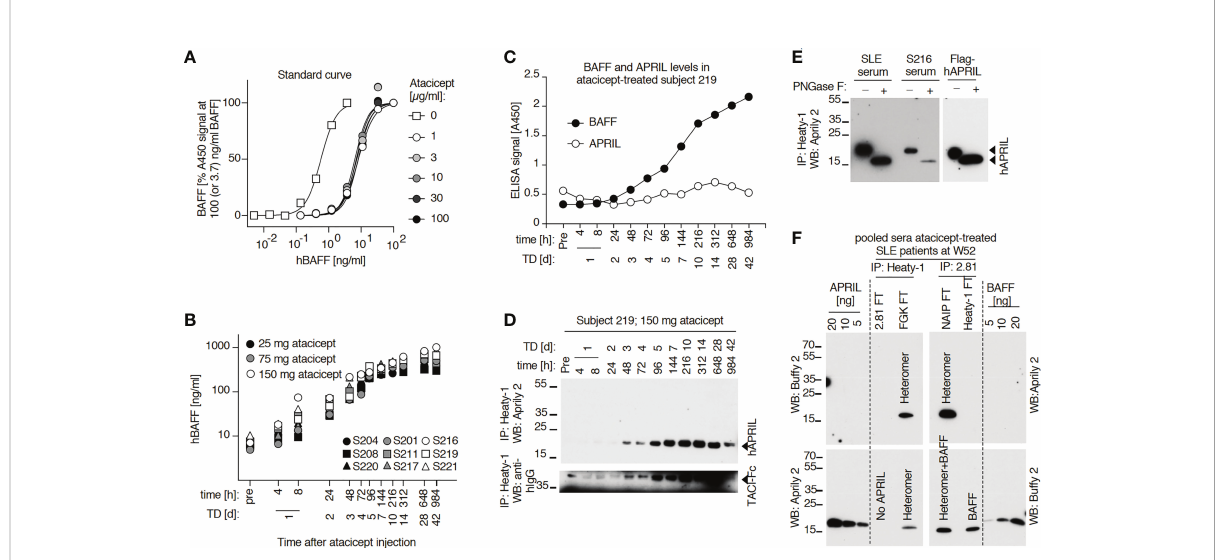
FIGURE 5 Serum levels of endogenous BAFF and BAFF-APRIL heteromers increase in a time-dependent manner after administration of atacicept. (A) hBAFF ELISA signals upon titration of a BAFF standard alone or in the presence of the indicated fi xed concentrations of atacicept.